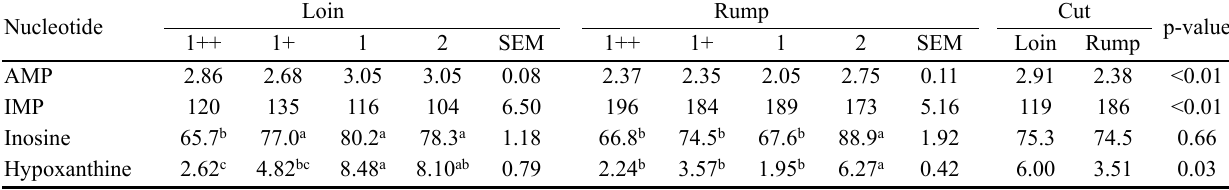
Table 6. Nucleotides contents (mg/100 g) of loin and rump with different quality grades in Korean cattle steers Nucleotide